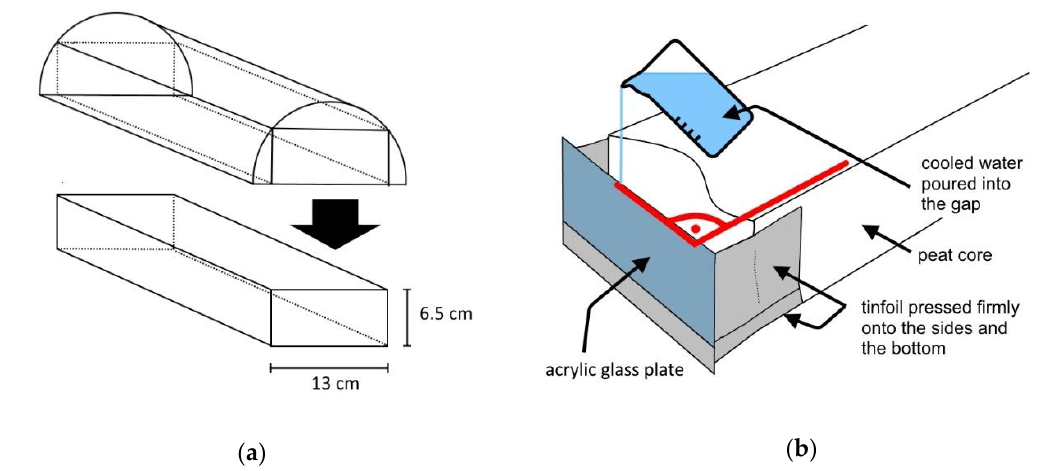
Figure 1. Preparation of the peat monolith: ( a ) Shape of the monolith before and after size adjustment. ( b ) Creation of the ice cap—an acrylic glass plate was positioned a few centimeters away from the plant and litter surface at a 90° angle to the sides of the core; it was attached to tinfoil that was then pressed firmly against the frozen peat. The core was placed in the freezer (−18 °C) and precooled water (+4 °C) was poured into the gap in 10 mL units for every 30 min until it was filled up entirely with ice.